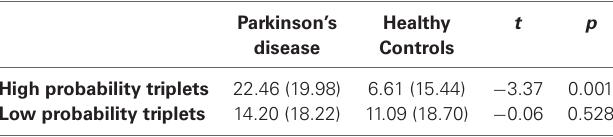
Table 3 | Mean reaction time increase from 1st to 2nd Half Blocks by Triplet type and Group . Parkinson’s disease